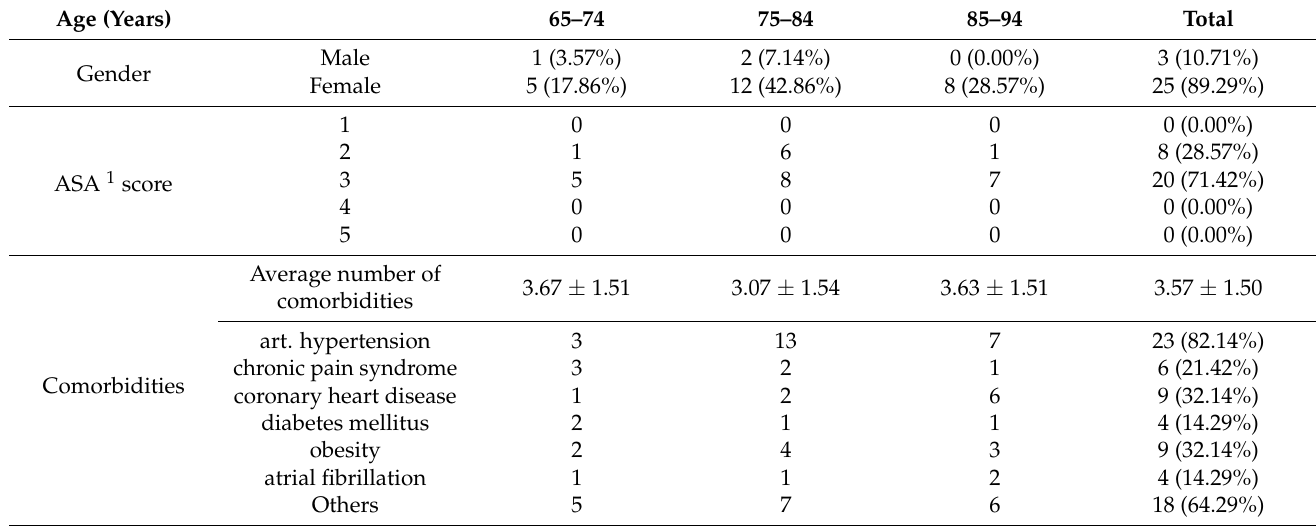
Table 1. Demographic data, fracture subtype and type of injury of our patient